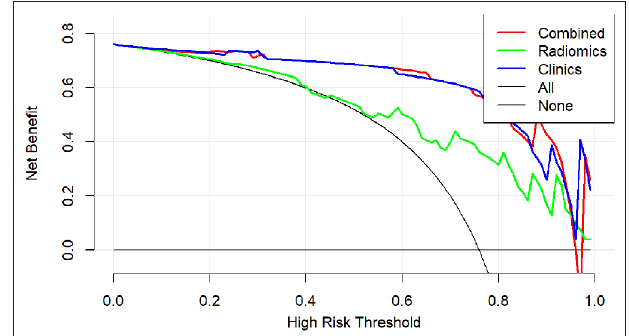
FIGURE 6 | Decision curve analysis of clinical use assessment of the radiomic nomogram in the validation group. The Y -axis represented the net benefit. The method was the best for feature selection if it had the highest net benefit. The radiomic nomogram (red line) achieved the highest net benefit compared with the radiomic signature (green line), clinical characteristics (blue line), treat-all strategy (gray line), and the treat-none strategy (horizontal black